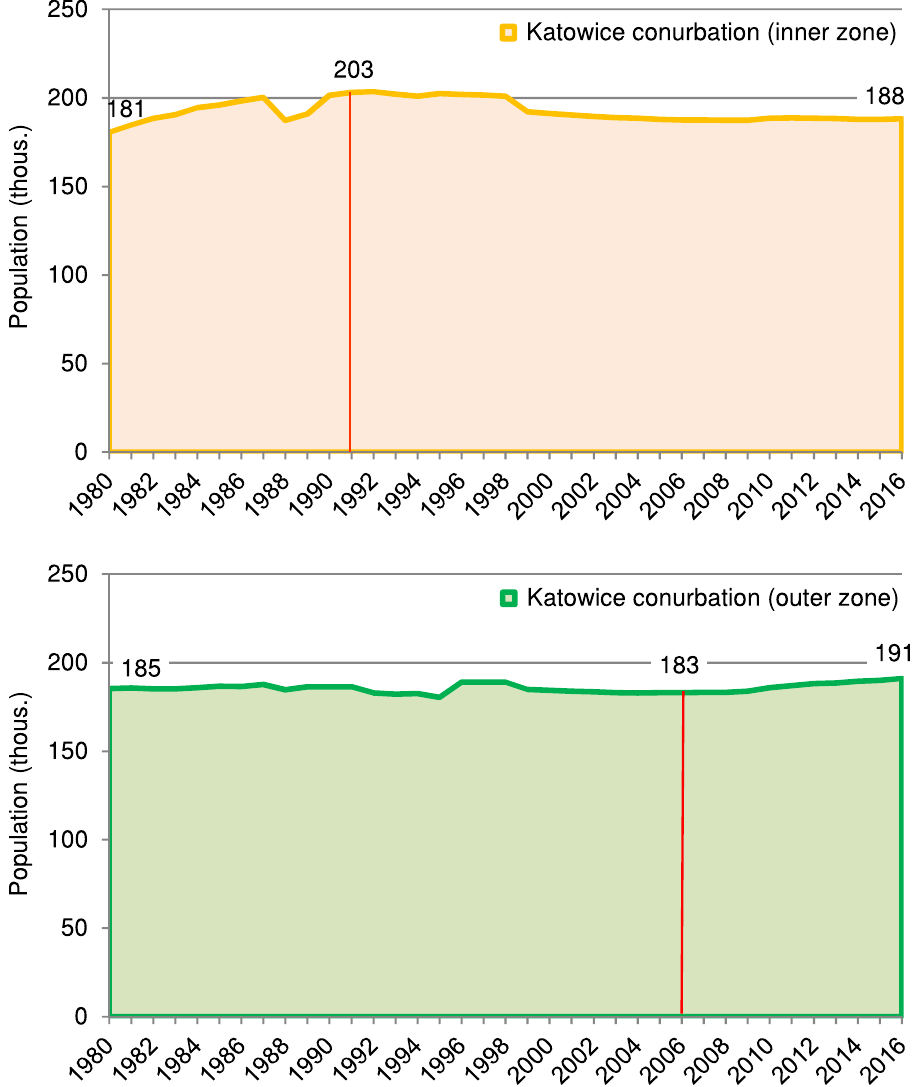
Fig. 2. Changes in the population of the Katowice conurbation (total), its core, inner and outer zones in the period 1980–2016 (Source: own elaboration based on Local Data Bank of the Central Statistical Office; Rocznik Statystyczny Województwa Katowickiego 1981,–1995, WUS,